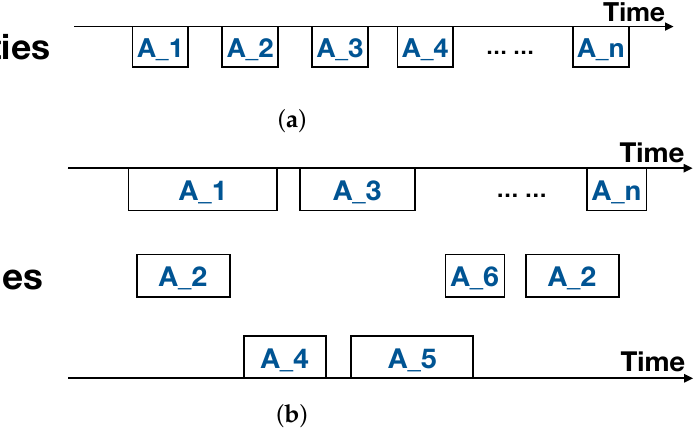
Figure 2. Comparison between the existing human activity recognition (HAR) approaches and the ground truth in the real world. ( a ) Result of the existing HAR approaches; ( b ) Activities in the real